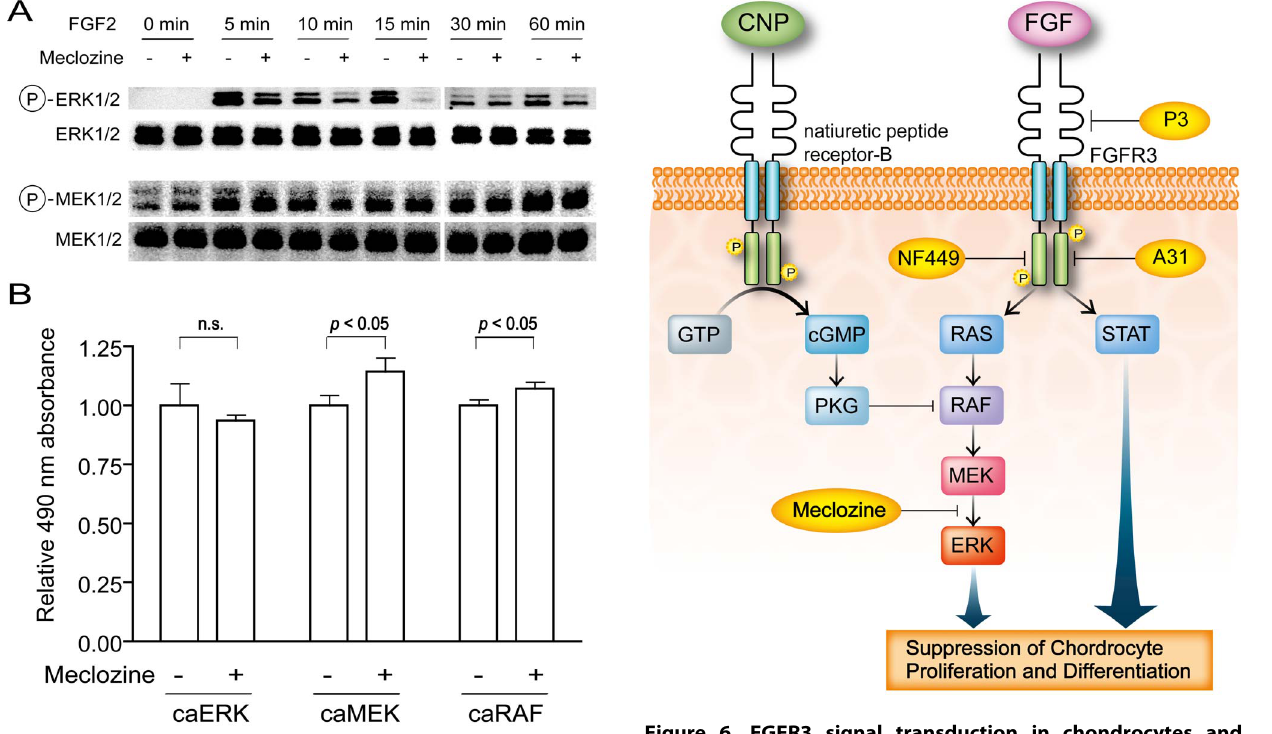
synthetic compound A31 is an inhibitor of the FGFR3 tyrosine kinase by in silico analysis. They demonstrated that A31 suppresses constitutive phosphorylation of FGFR3 and restores the size of embryonic femurs of Fgfr3 Y367C/ + mice in organ culture. In addition, A31 potentiates chondrocyte differentiation in the Fgfr3 Y367C/ + growth plate [16]. Jin et al. screened a library of random 12-peptide phages and found that P3 has a high and specific binding affinity for the extracellular domain of FGFR3. They showed that P3 promotes proliferation and chondrogenic differentiation of cultured ATDC5 cells, alleviates the bone growth retardation in bone rudiments from TD mice ( Fgfr3 Neo-K644E/ + mice), and finally reversed the neonatal lethality of TD mice [15]. These novel FGFR3 tyrosine kinase inhibitors, however, may inhibit tyrosine kinases other than FGFR3 and may exert unexpected toxic effects in humans. Meclozine may also inhibit unpredicted tyrosine kinase pathways, but we can predict that